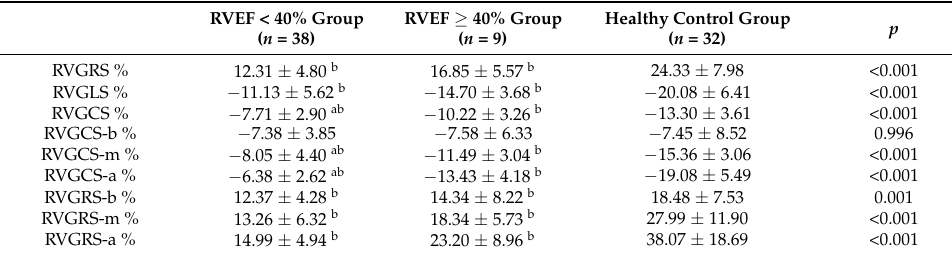
Table 4. Comparison of RV strain parameters among PAH patients with reduced and preserved RV function and healthy